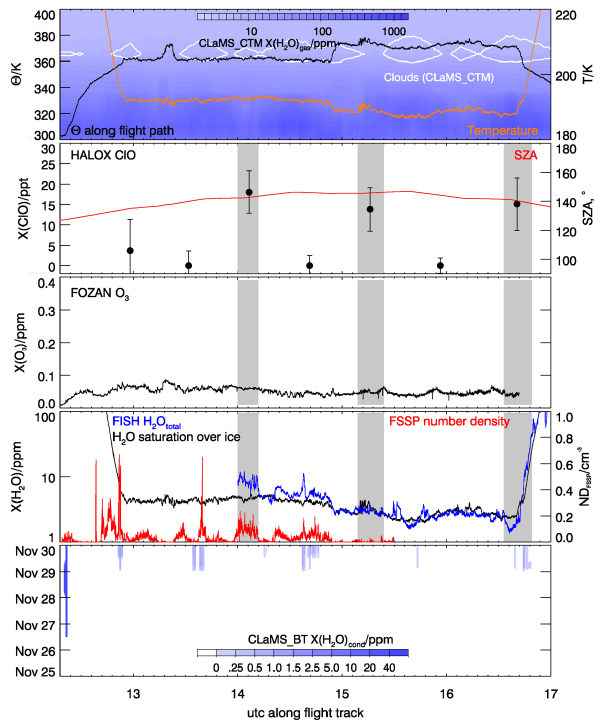
Fig. 7. As Fig. 6 but for the flight on 30 November 2005.